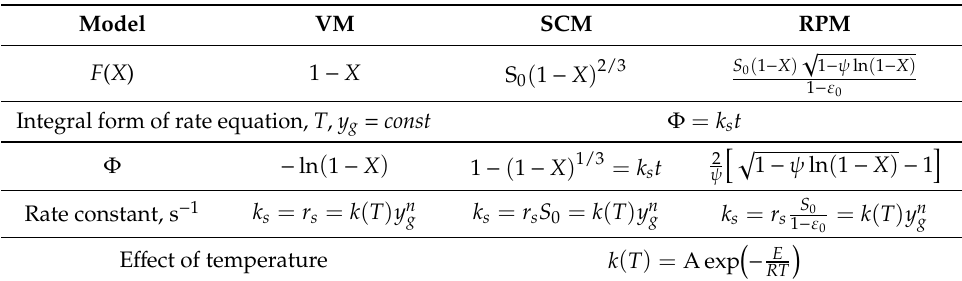
Table 1. Equations of the reaction rate models for gas–solid reactions [20]. Model VM SCM RPM